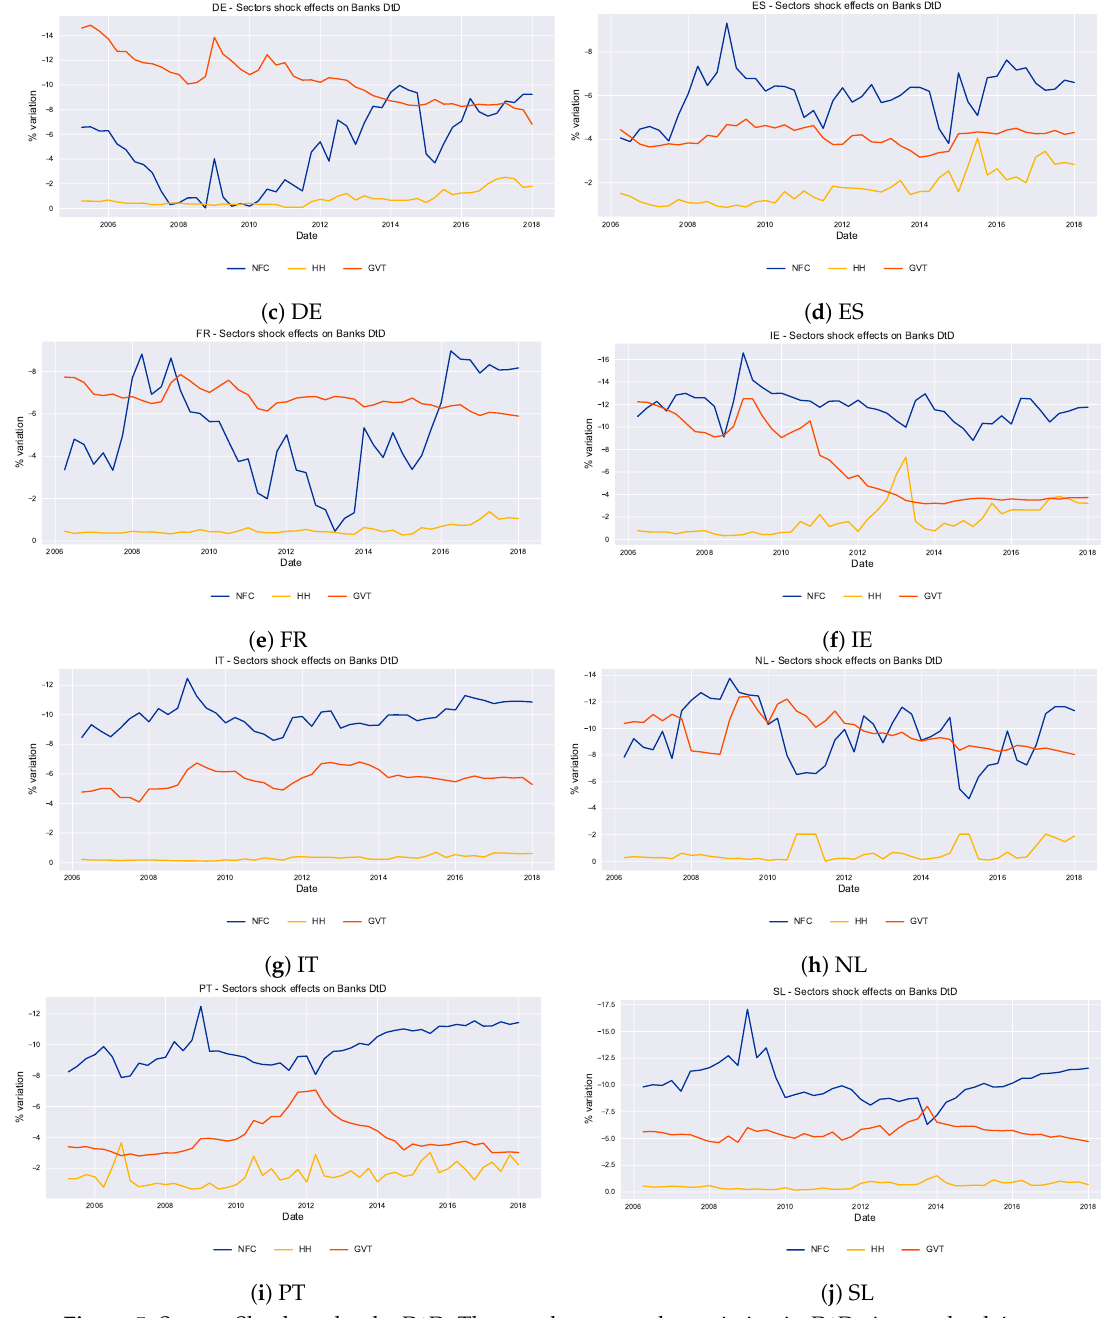
Figure 5. Sectors Shocks to banks DtD . The panels present the variation in DtD given a shock in one of the analysed counterparty sectors (HH, NFC, GVT). For the first two sectors we employed a 20% shock on E and σ E (negative to the former, positive to the latter). For the government sector we employ a 200 basis points positive shock on the CDS spead. The shock is separately applied on each sector and for each point in time (each quarter from beginning 2005 to end 2017). The blue line represents the shock from NFC, the yellow line the impact of a variation in HH and, lastly, the red line represents the impact of a shock in GVT CDS